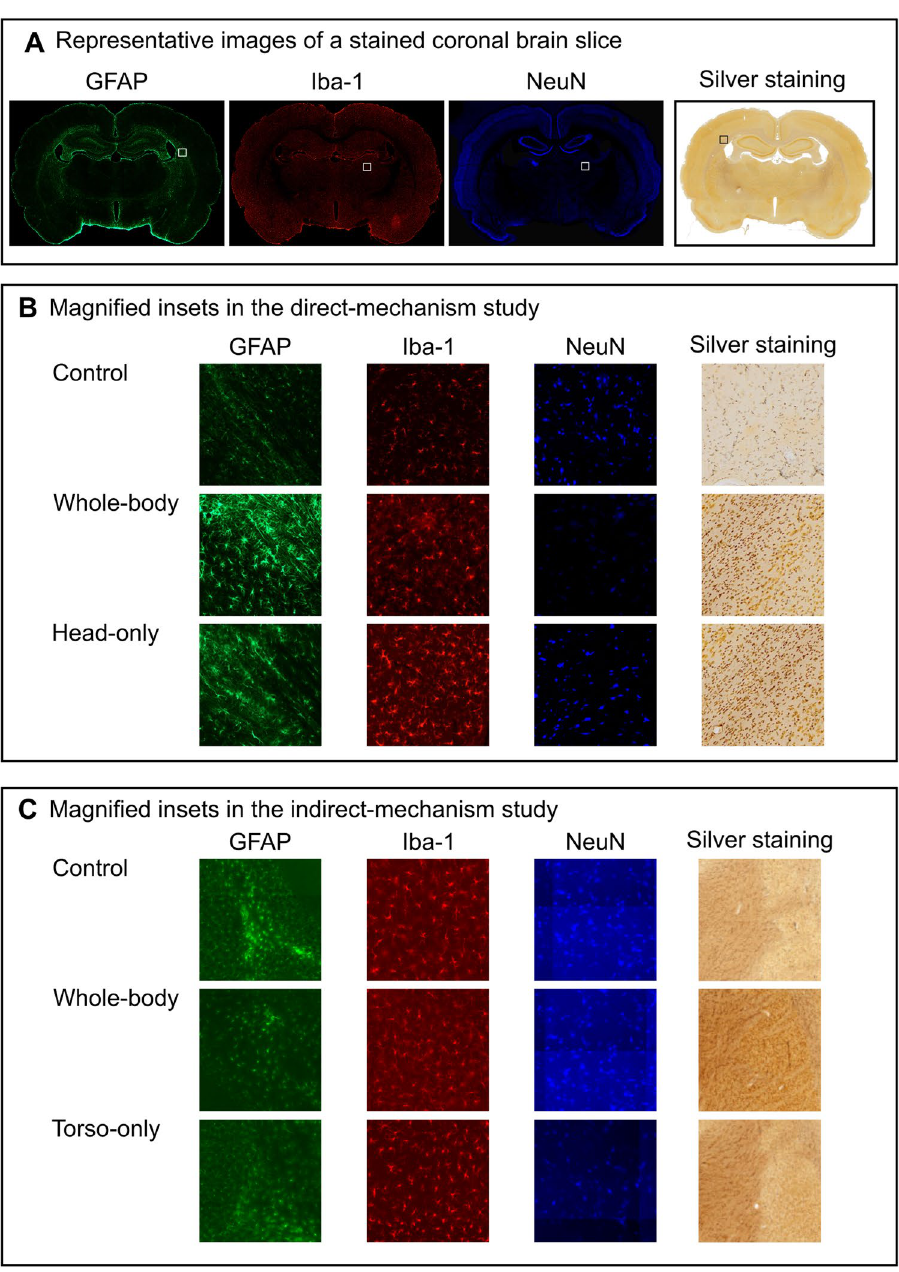
Figure 2. Representative images of immunohistochemical- and histopathological-stained coronal brain slices. In both the direct- and indirect-mechanism studies, we conducted immunohistochemical analyses on the coronal brain slices harvested from control and blast-exposed rats to assess the distribution of astrocytes, microglia, and neuronal cells using GFAP, Iba-1, and NeuN staining, respectively. In addition, we conducted histopathological analyses using silver staining to assess for neuronal degeneration. After staining, we digitized each coronal brain slice with a 10-× magnification using bright-field for histopathological analysis and fluorescence filters for immunohistochemical analyses. ( A ) Representative images of each staining assessment in a coronal brain slice located at − 2 mm relative to Bregma. ( B , C ) The magnified insets show examples of stained cells in coronal brain slices of control and blast-exposed rats ( B ) in the direct-mechanism study and ( C ) in the indirect-mechanism study. Note that the images in panel ( C ) representative of the indirect mechanism are not illustrated here in high resolution because the acquisition software in this study did not allow us to export the high-resolution images used in the